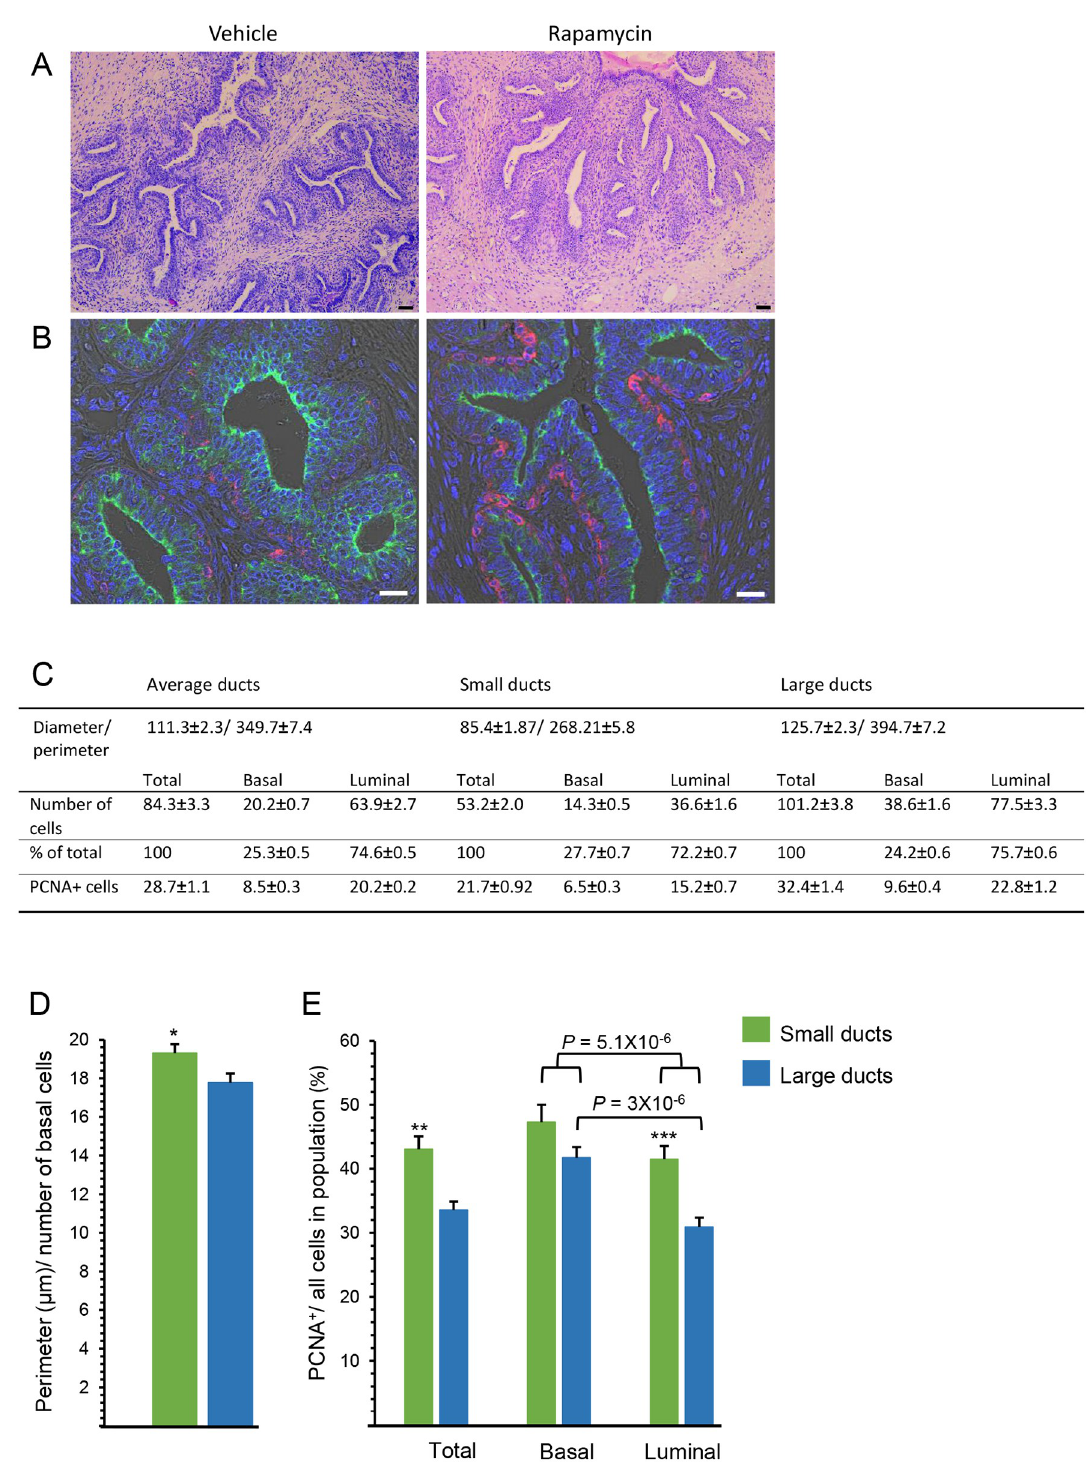
Fig 4. Morphological and proliferative characteristics of 3-month-old vehicle-treated and rapamycin-treated bovine mammary gland after 4-day treatment with estrogen and progesterone. A. Representative H&E staining of vehicle- and rapamycin-treated glands. Bar = 50 μ m. B. Immunofluorescence analysis demonstrating multilayered luminal cells stained with CK18 (green) and a single layer of basal myoepithelial cells stained with α SMA (red). Bar = 20 μ m. C-E. Mammary ductal cell characteristics of the vehicle-treated gland. C. Diameter size distinguishes small from large ducts. D. Density of basal cells in the ductal perimeter is higher in large vs. small